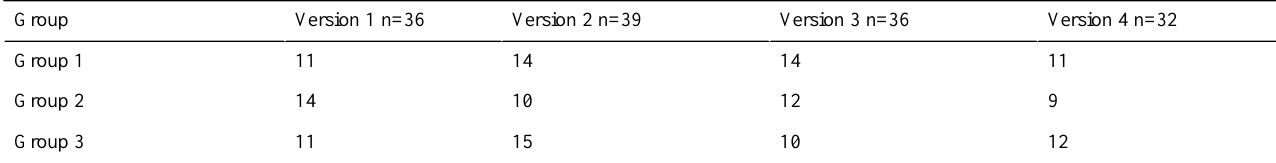
Table 6. Numbers of patients in the different groups.